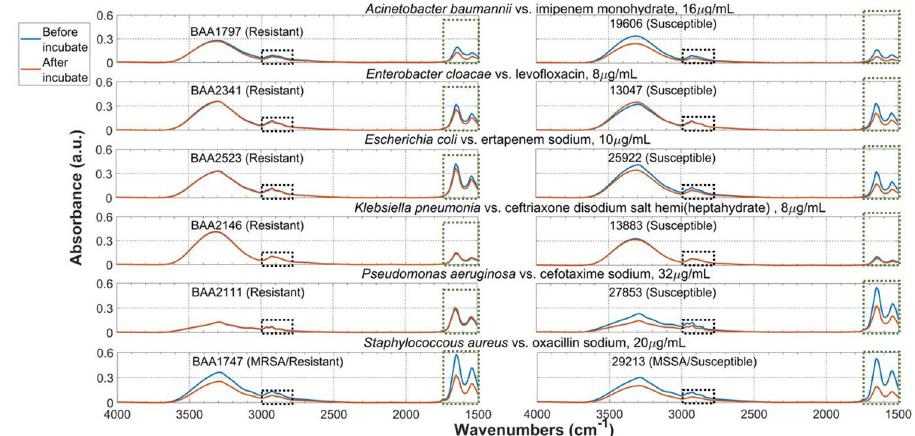
Fig 1. Specificity of the ATR system. Compare averaged ATR spectra of the bacteria cell before and after incubation with antimicrobial solution at 35˚C for 4 hours. Consistent spectral changes are observed in two highlighted spectra